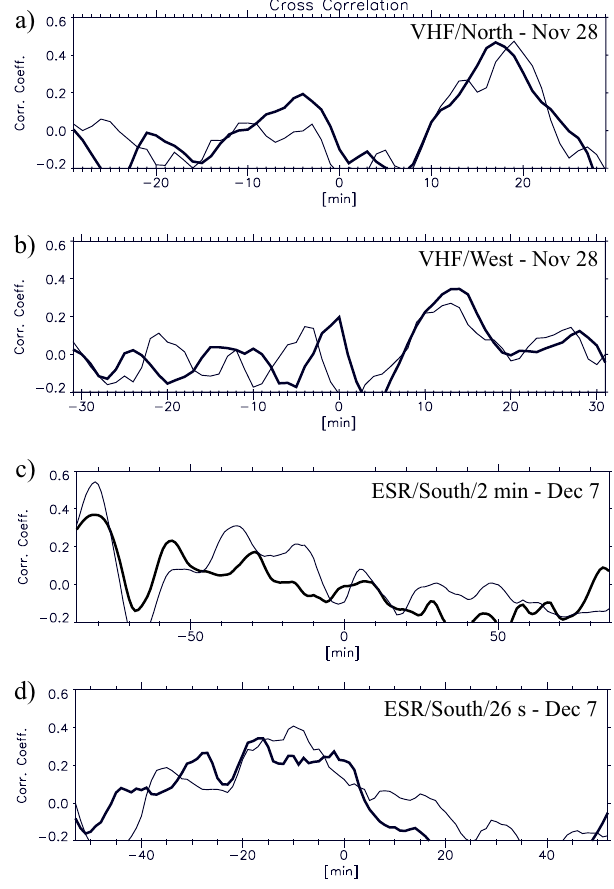
Fig. 12. Cross correlation with the solar wind electric field for the 4 data sets, using ACE data (thick line) and Wind data (thin line). Solar wind data are time shifted to the sub solar magnetosphere (X=10 R E